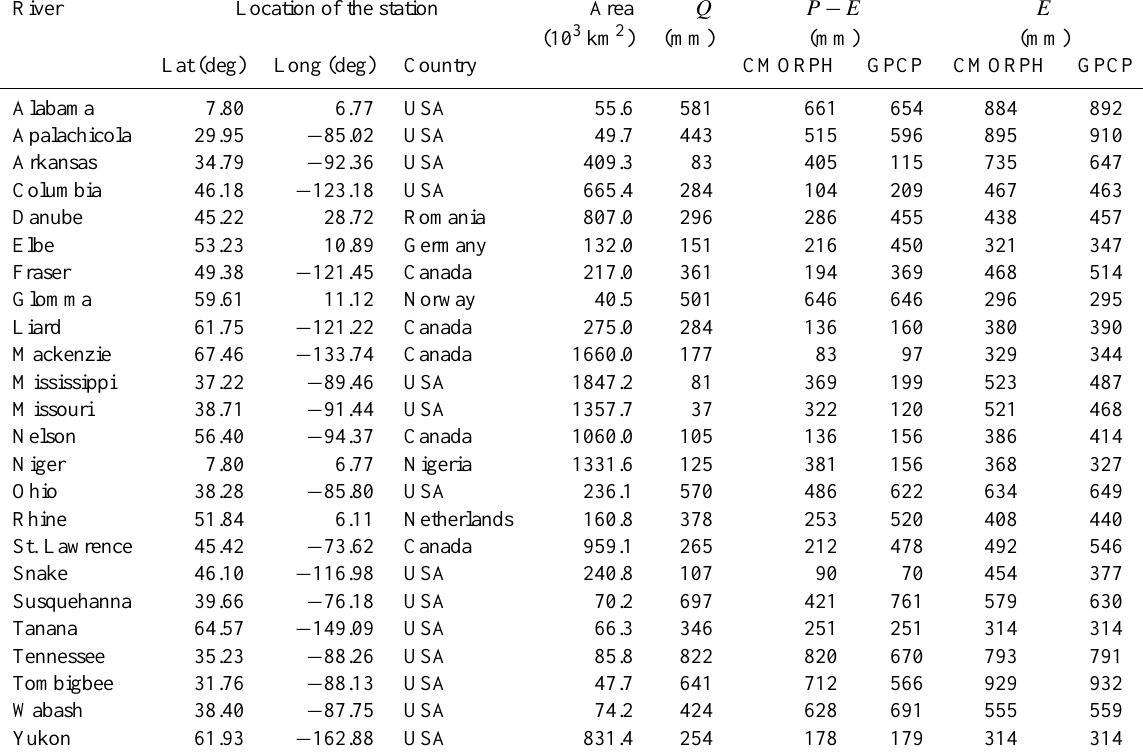
Table 1. GRDC stations used in the comparison of P − E and observed annual river runoff ( Q ). Results correspond to the period 2003–2006. River